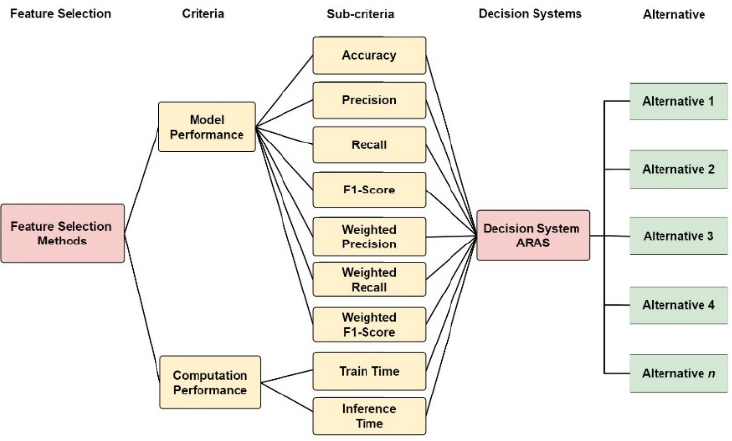
Figure 2. Schematic diagram of decision model to evaluate feature selection methods.